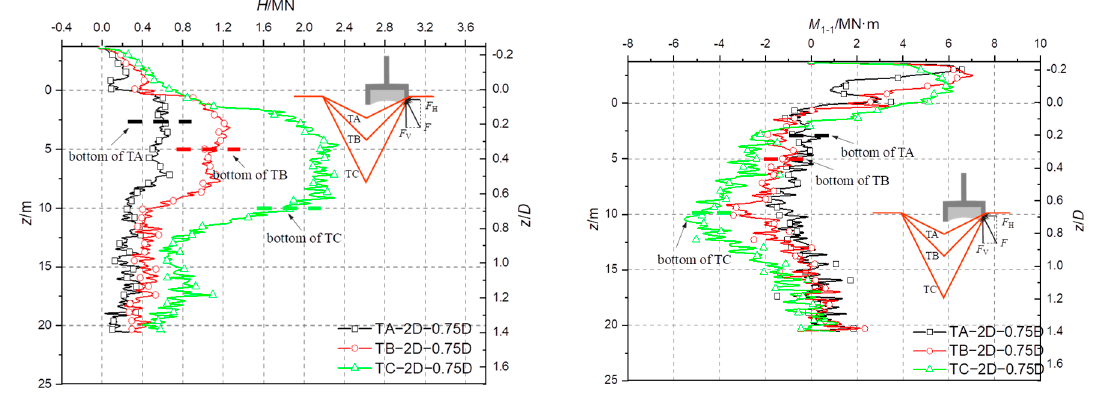
( c ) Effect of footprint geometry on skirted footing ( β = 0.75 D ) Figure 17. Effect of footprint geometry on three types of footings. Figure 17. E ff ect of footprint geometry on three types of